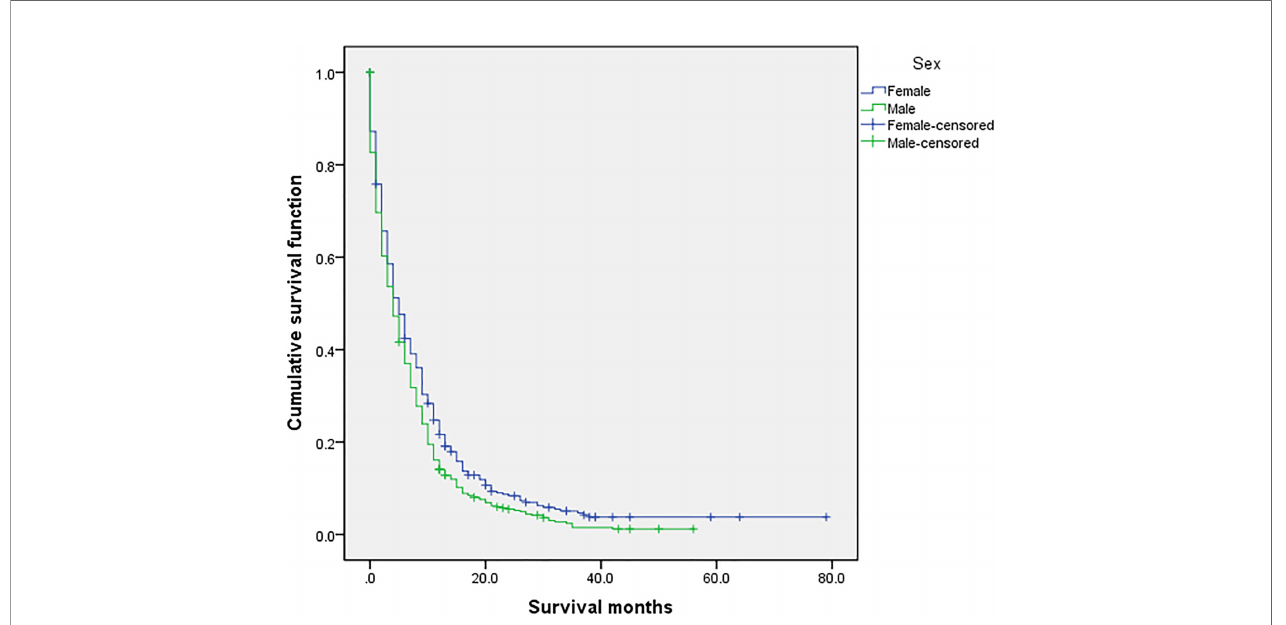
FIGURE 3 | Univariate analysis of female and male. In the organ metastasis group (n = 870), univariate analysis of female and male showed that P =0.003 was obtained by Kaplan – Meier survival analysis log rank (mental Cox). There was signi fi cant difference between the two groups.